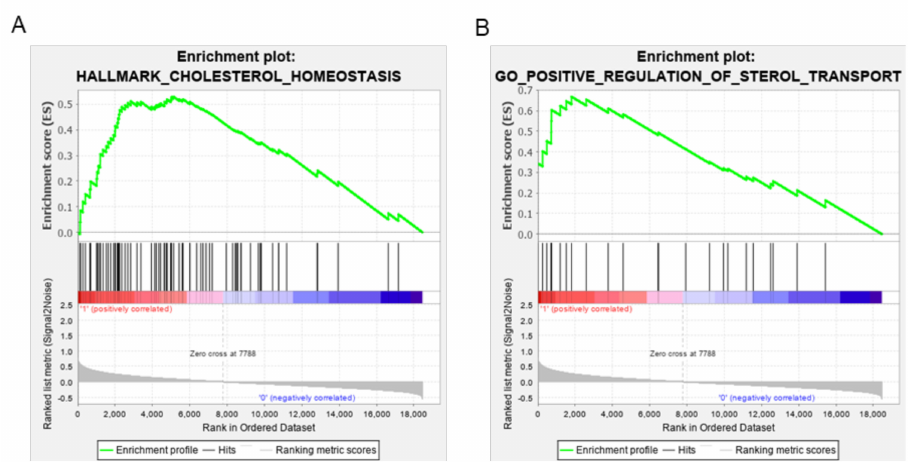
Figure 4. Gene set enrichment analysis (GSEA) showing EOC tumours with high ABCA1 are enriched for expression of gene sets associated with cholesterol metabolism. ( A ) GSEA showing enrichment in the Hallmark gene set involved in cholesterol homeostasis. p = 0.008 and false discovery rate (FDR) = 0.021. ( B ) GSEA showing enrichment in the Gene Ontology (GO) gene set involved in positive regulation of sterol transport. p < 0.001 and FDR = 0.069. n =